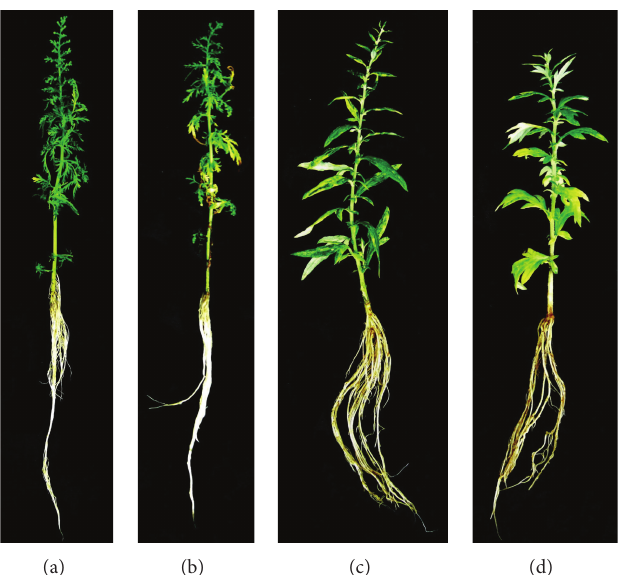
Figure 1: Morphological response of A. scoparia and A. vulgaris “Variegate” to salt stress. (a), (c) The plants of A. scoparia and A. vulgaris “Variegate” grown under controls, respectively. (b), (d) The plants treated with NaCl,